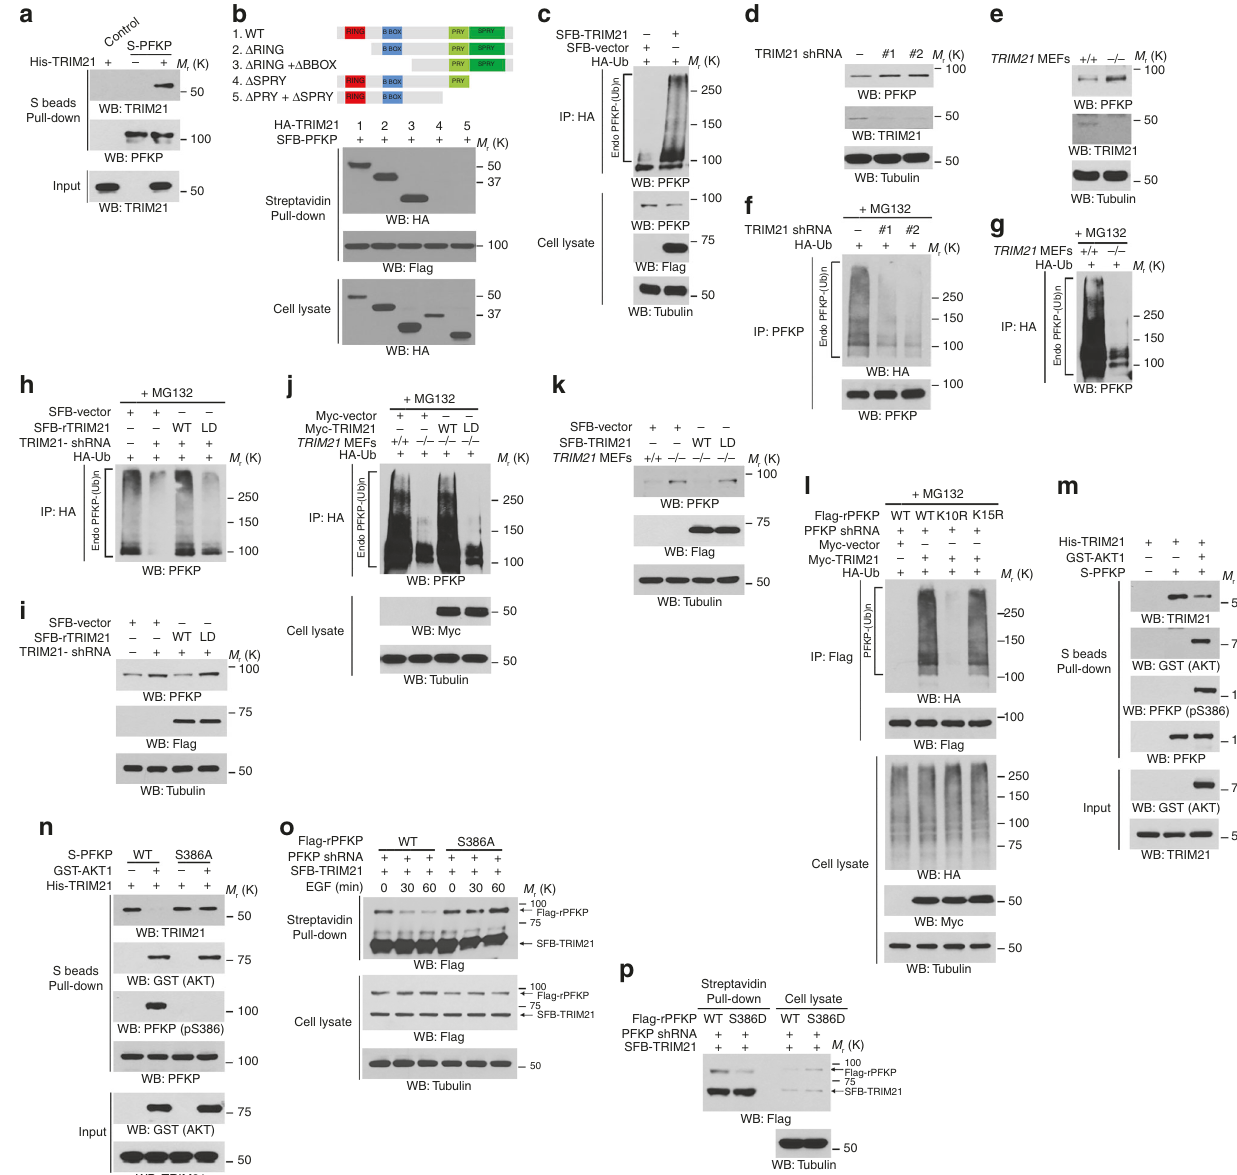
Streptavidin Pull-down Cell